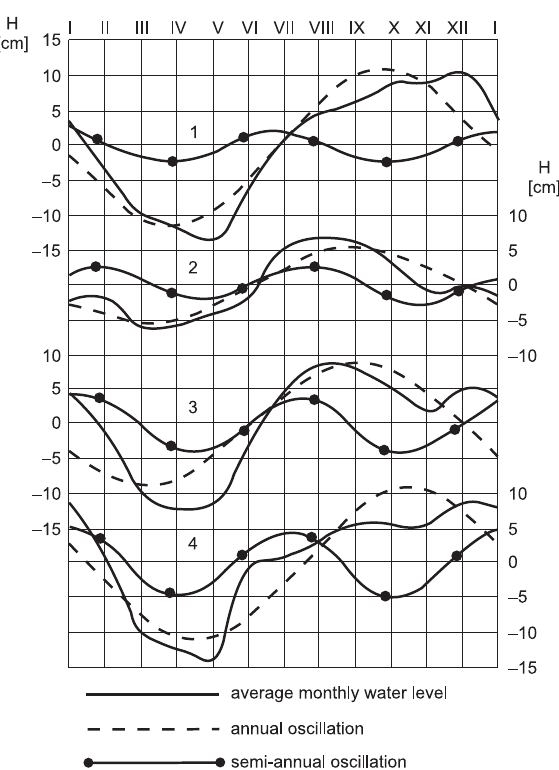
Fig. 13. Annual and semi-annual oscillation in comparison with an average, the observed annual sea level (1891–1960) in [cm] at stations: 1. Ejsberg – North Sea, 2. Gedser – Dan- ish straits, 3. Landsort – the central part of the Baltic Sea, 4 Oulu – Gulf of Bothnia (Wiśniewski 1978). Seasonal fluctua- tions associated with the water balance are only background against which occur short-term fluctuations. Therefore it should be assessed as a long-term seasonal variations in the change of average water